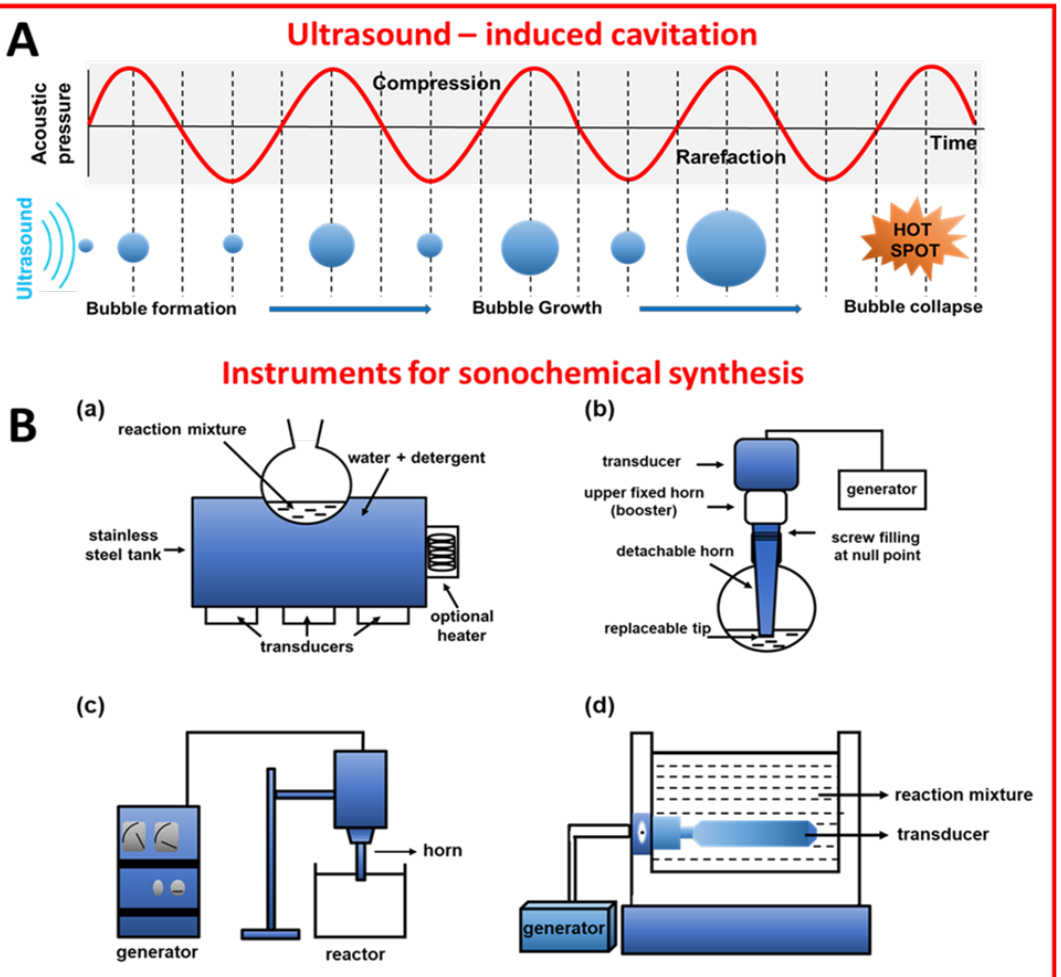
Figure 1. ( A ) Schematic illustration of ultrasound-induced cavitation [6]. Reproduced with